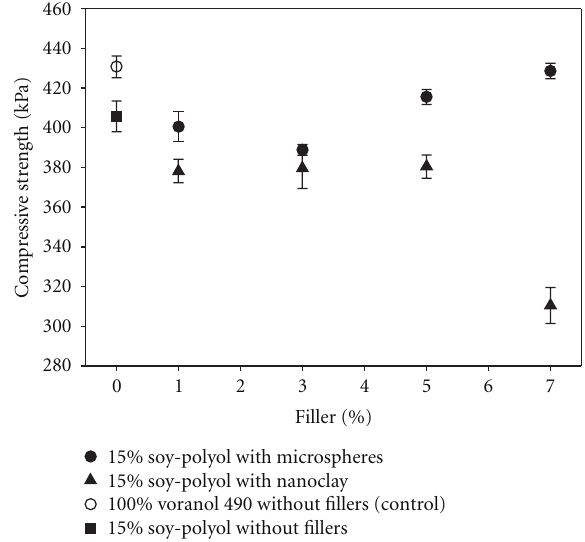
Figure 2: The e ff ect of microspheres and nanoclay on compressive strength of SBO